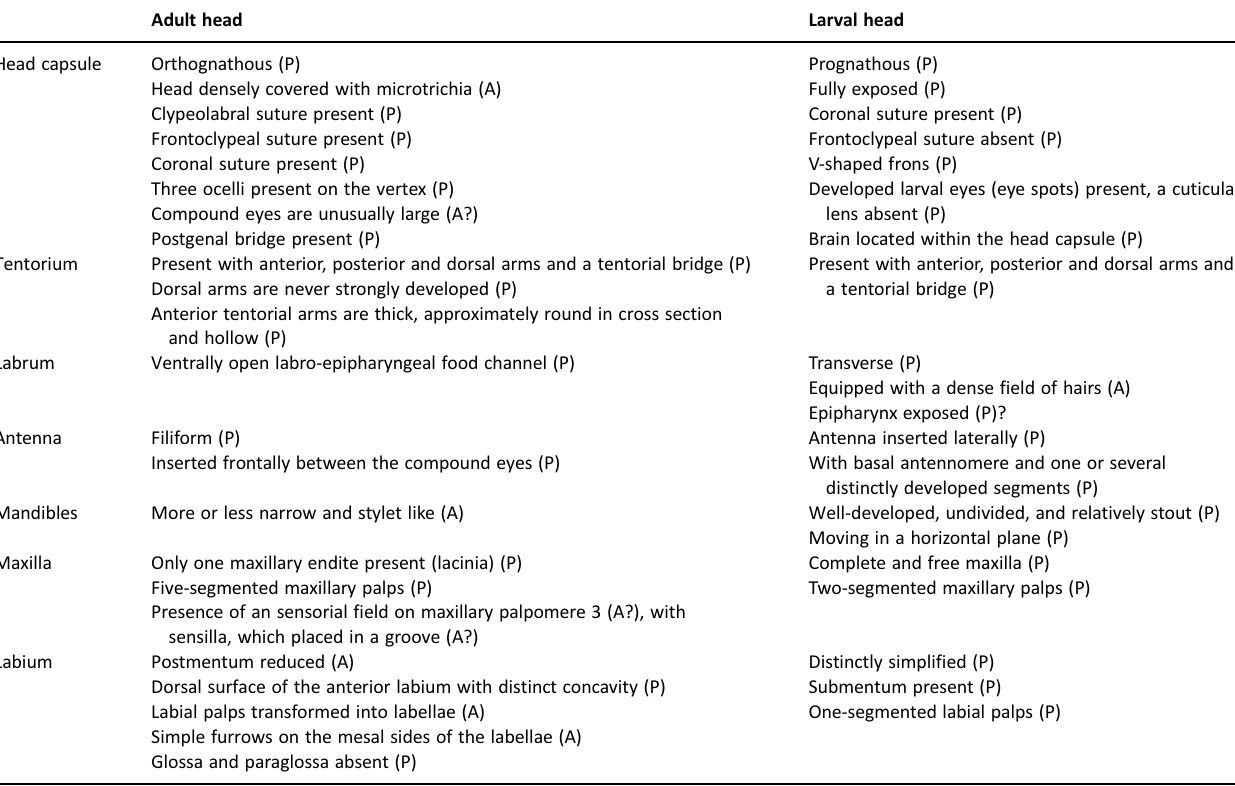
Table 3. Groundplan features of the adult and larval